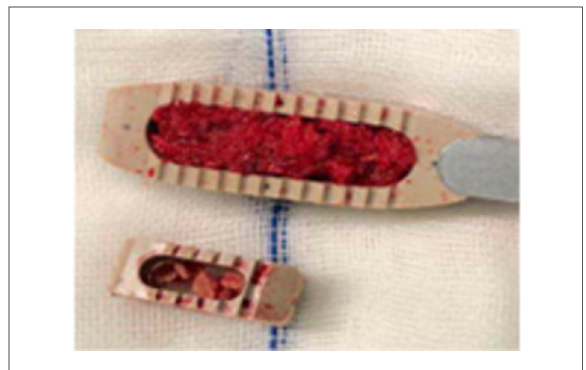
FIGURE 5 The bigger cage of OLIF has more graft bone and more touch surface than that of MIS-TLIF. OLIF, oblique lumbar interbody fusion; MIS-TLIF, minimally invasive surgery-transforaminal lumbar interbody fusion.